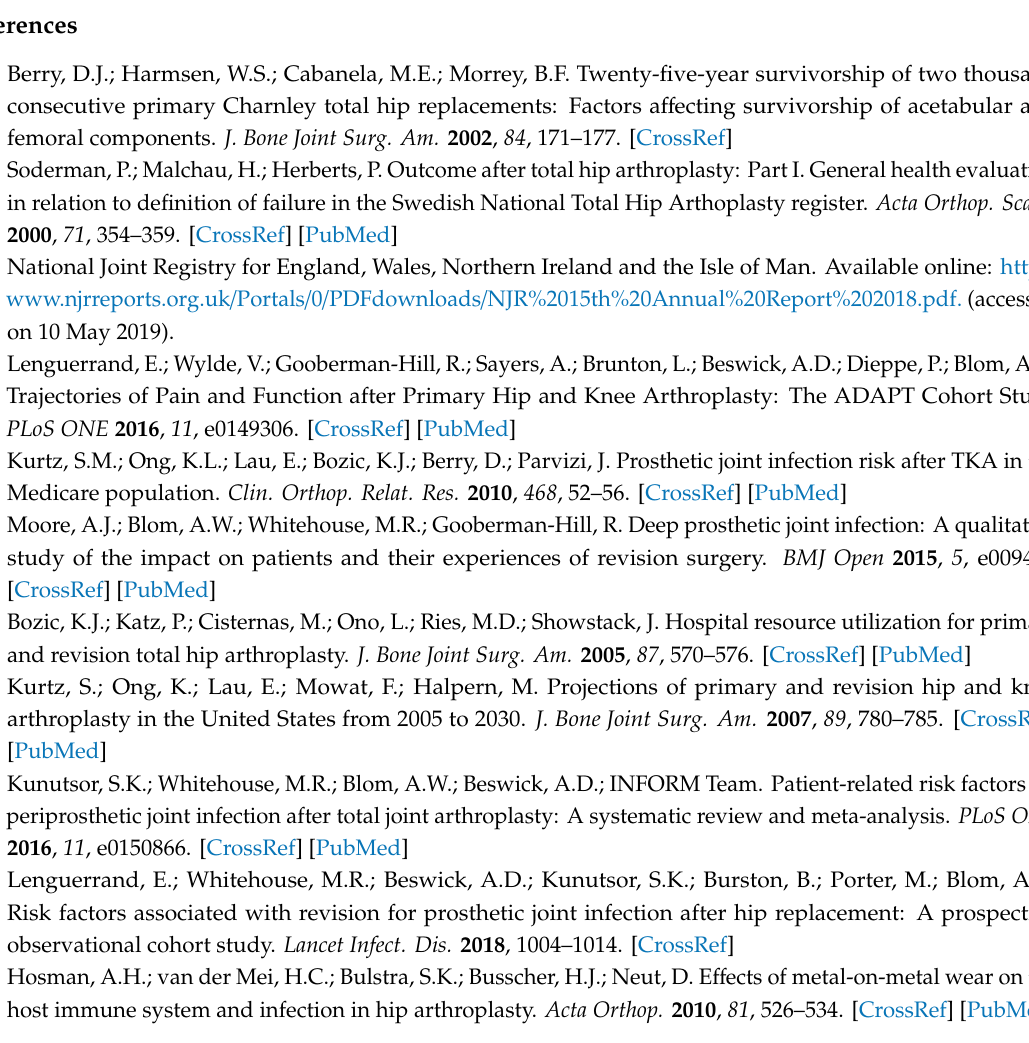
Table S1: PRISMA checklist, Table S2: MOOSE checklist, Table S3: Literature search strategy, Figure S1: Assessment of risk of bias in randomised controlled trials, Figure S2: Comparison of all cemented fixation with uncemented fixation and the risk of prosthetic joint infection in observational studies, Figure S3: Comparison of plain cemented fixations with antibiotic-loaded cemented fixations and the risk of prosthetic joint infection in observational studies, Figure S4: Comparison of hybrid fixation with uncemented or all cemented fixations and the risk of prosthetic joint infection in observational studies, Figure S5: Comparison of reverse hybrid fixation with uncemented or all cemented fixations and the risk of prosthetic joint infection in observational studies, Figure S6: Comparison of fixation types and the risk of prosthetic joint infection in interventional studies, and Figure S7: Assessment of small study e ff ects by funnel plots and Egger’s regression symmetry